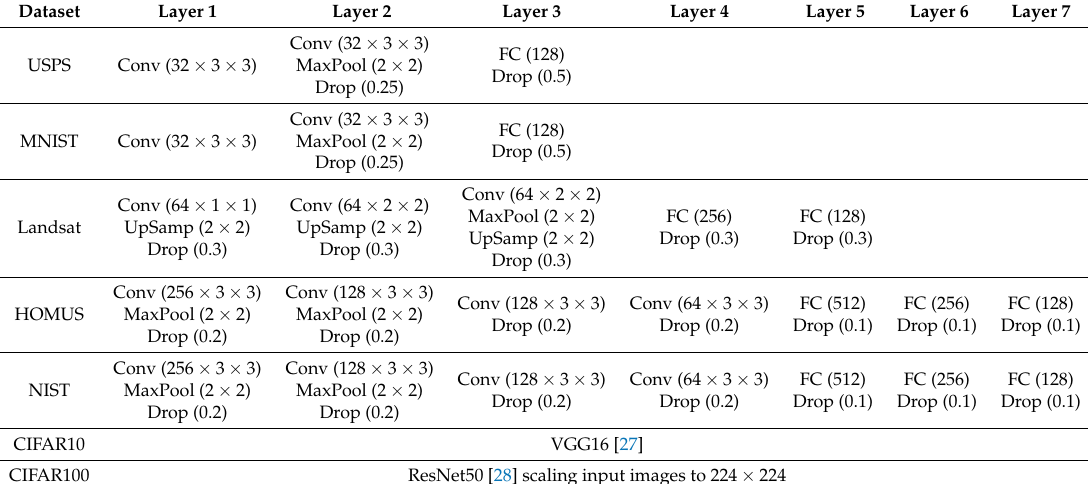
Table 2. CNN architectures evaluated with each image dataset. Conv( f × w × h ) stands for a layer with f convolution operators with w × h kernel; MaxPool( w × h ) stands for the max-pooling operator with w × h kernel; UpSamp( w × h ) stands for an up-sampling operator with w × h kernel; Drop( d ) refers to dropout with ratio d ; and FC( n ) mean a fully-connected layer with n